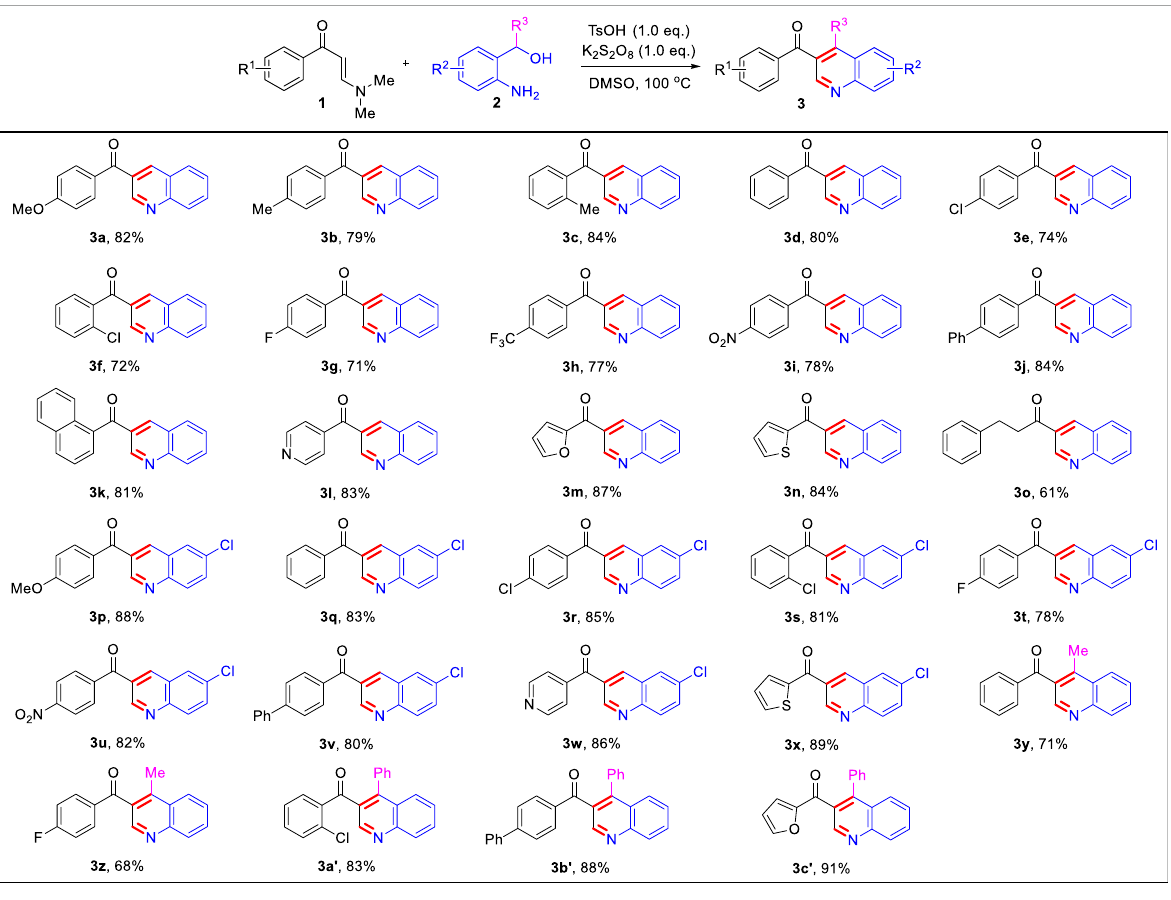
TABLE 2 Scope of substrates.